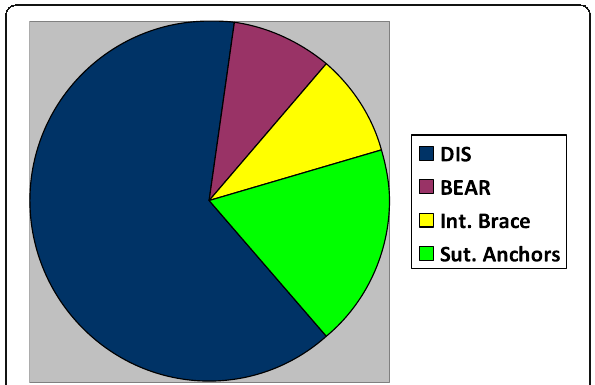
Fig. 4 Pie chart illustrating the proportion of clinical studies included in the review that dealt with DIS, BEAR, internal brace and suture anchors. DIS: dynamic intraligamentary stabilization, BEAR: bridge- enhanced ACL repair, Int. Brace: internal brace, Sut. Anchors: suture anchors, ACL: anterior cruciate